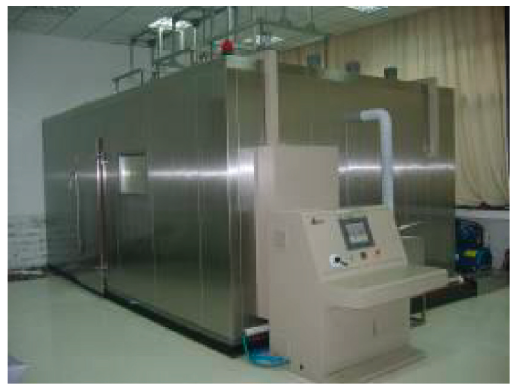
Figure 1: Artificial climate simulation and